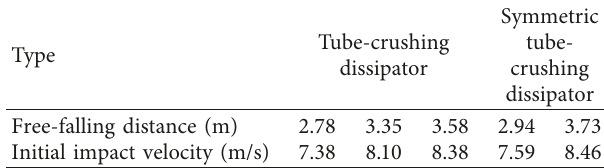
Table 2: Free-falling distances and initial impact velocities in the dynamic